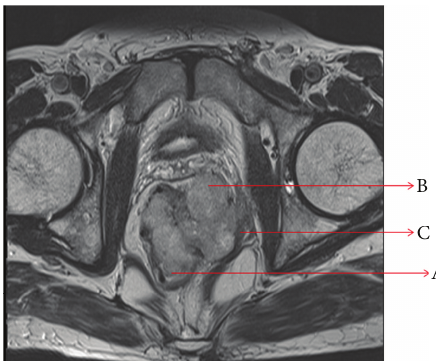
Figure 2: T2W axial image through distal rectum showing partly endophytic (A) and partly exophytic (B) mass having intermediate signal intensity. Left puborectalis muscle is invaded, thickened, and retracted (C).